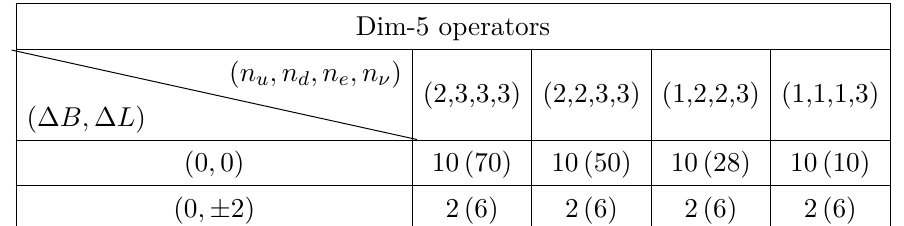
Table 4 . The number of types (operators) of each baryon-number and lepton-number violation pattern with various flavors involved at dimension 5. n of up-type quarks, down-type quarks, charged leptons and neutrinos respectively. For n n u = 1 , the corresponding active up-type quarks are ( c, u ) and ( u ) respectively, For n d = 3 , 2 , 1 , active down-type quarks are ( b, s, d ) , ( s, d ) and ( d ) respectively, n charged letpons ( τ, µ, e ) , ( µ, e ) and ( e ) . The number of active neutrino are always set to 3. The only type of (0 , ± 2) at dimension 5 is F numbers stay the same.